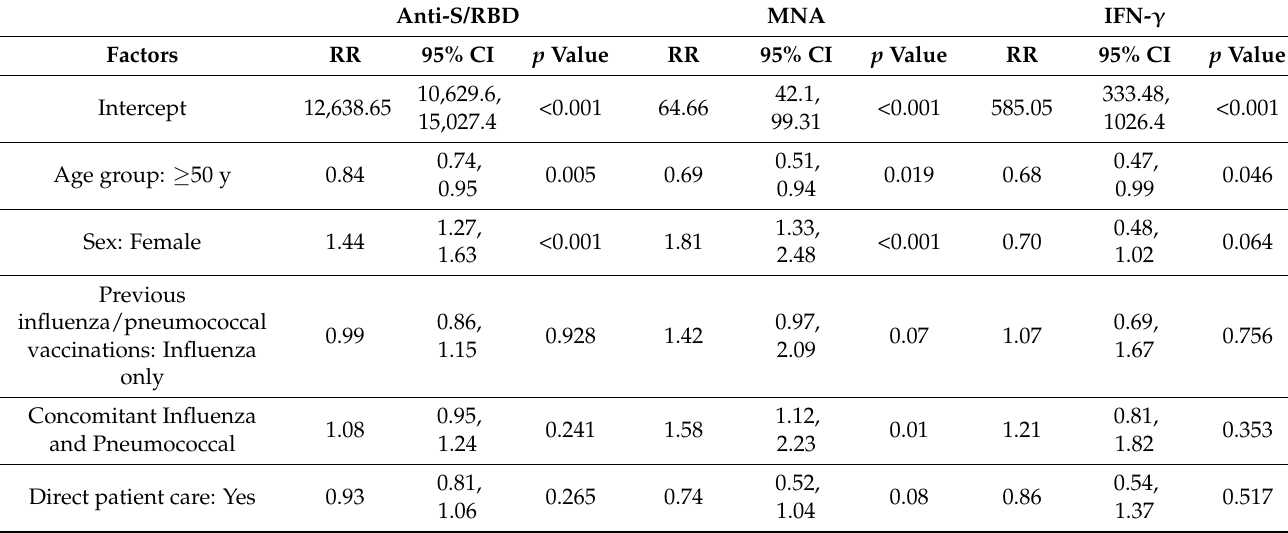
Table 2. Multiple regression with log-transformed anti-S/RBD, MNA, and IFN- γ titers elicited by BNT162b2 vaccine according to studied variables.